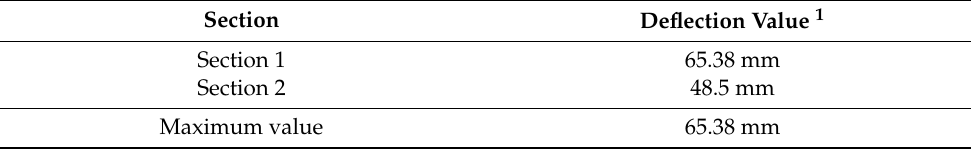
Table 6. Deflection value of each section (Campus building B).